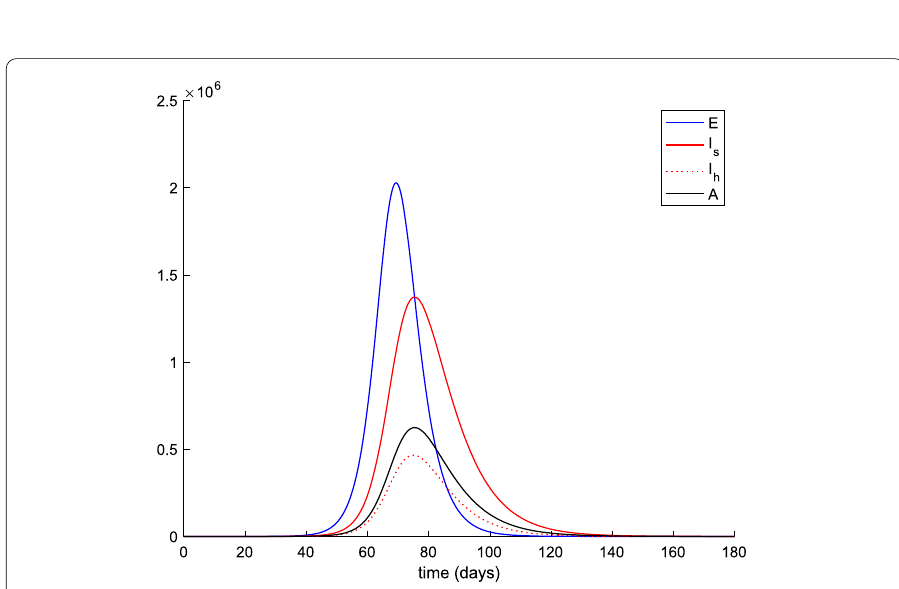
Figure 1 Evolution of susceptible and recovered in the absence of control